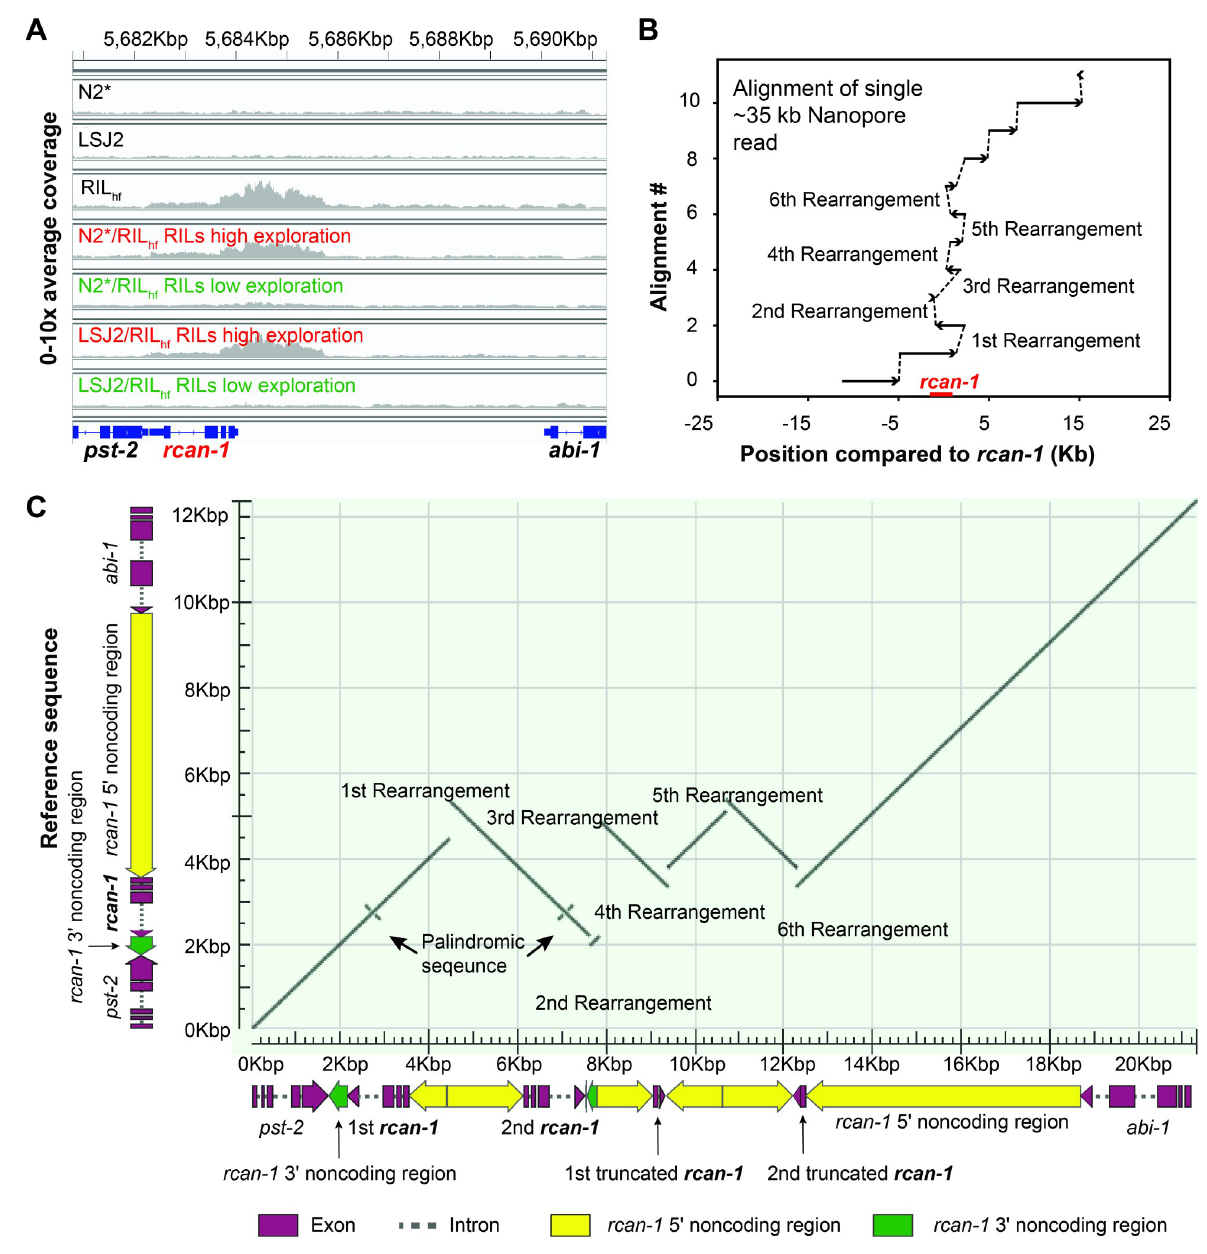
Fig 4. A de novo , complex rearrangement in rcan-1 in the RIL hf strain. (A) Illumina resequencing of the RIL hf strain identified an increase in coverage at the rcan-1 locus that was not present in either the N2 � or LSJ2 parental strains. This increase in coverage was linked with high exploration in both RIL panels, consistent with a role in exploration behavior. We were unable to resolve the exact nature of the genetic change using the short reads. (B) A single ~34.5 kb read from an Oxford Nanopore Minion resolved the rcan-1 rearrangement. This read was aligned to the N2 reference using blastn. Alignments are numbered on the y axis. Alignment gaps can be caused by either poor sequence quality of the read, or by genomic rearrangements in the RIL hf strain. The x-axis shows the position of the read relative to rcan-1 . To resolve the junctions, we used chimeric reads from the Illumina resequencing in (A). (C) Dot plot of the rcan-1 rearrangement. The y-axis shows the reference sequence of rcan-1 , and the x-axis shows the rearrangement in the RIL hf strain. A total of six new junctions was observed, causing changes to the rcan-1 locus shown under the x-axis. Palindromic sequences at the 3 rd intron of rcan-1 gene body are also shown.